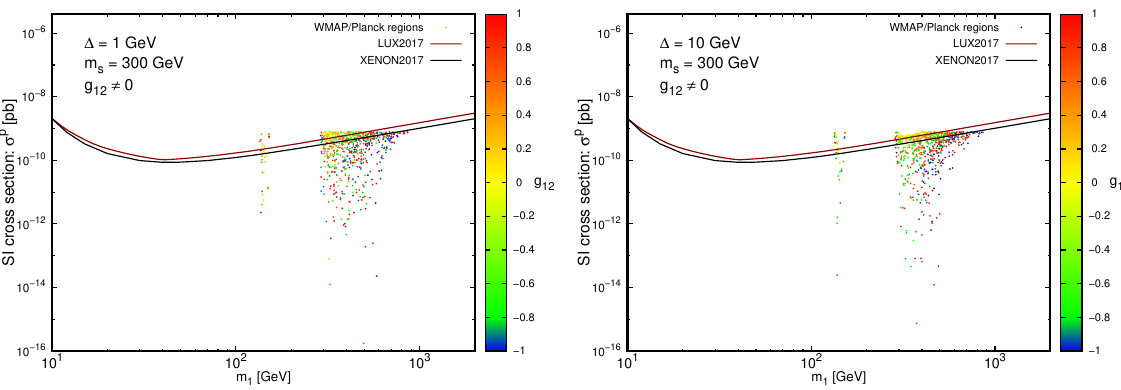
Figure 5 . The DM-proton (SI) scattering cross section as a function of DM mass for the mass split- ting (cid:1) = 1 ; 10 GeV. The singlet scalar mass is m s = 300 GeV and the mixing angle is sin (cid:18) = 0 : 05.